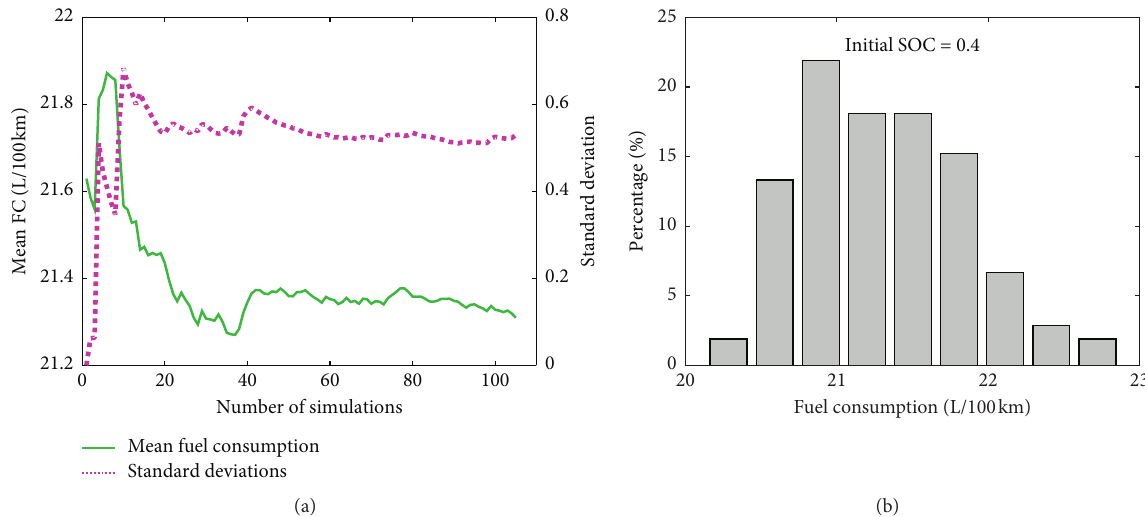
Figure 27: Mean FC, std. dev., and FC distribution for the measured data (initial SOC � 0.4). (a) Mean FC and std. dev and (b) distribution of the FC.